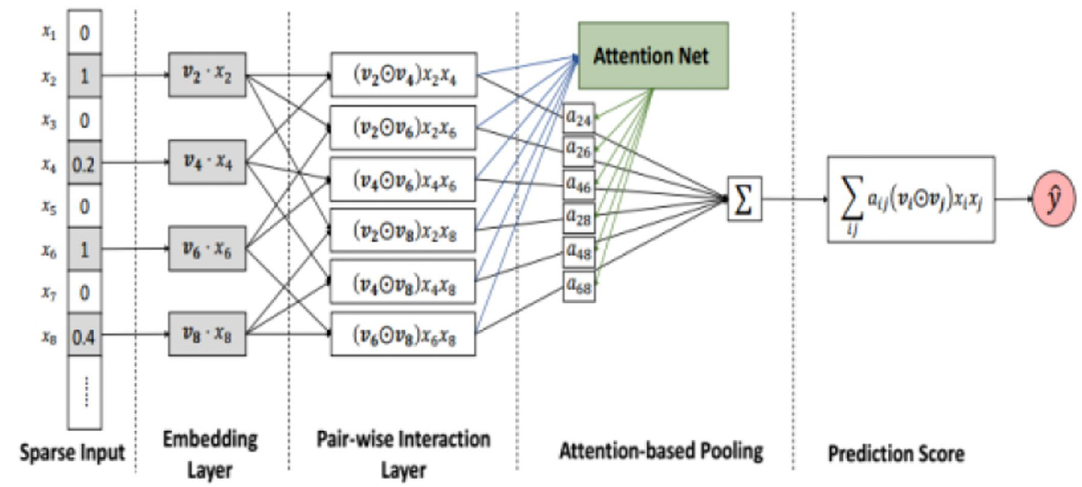
Fig. 2 Network topology of the AFM